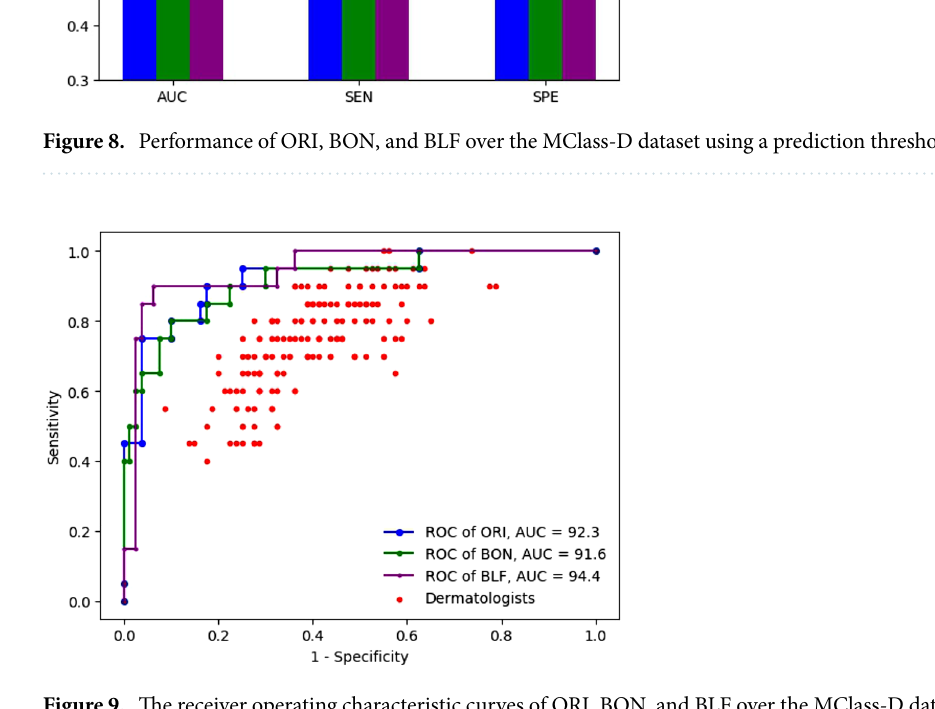
Comparison of the systems’ performance to that of dermatologists based on ROC curves. Figure 9 shows the ROC curves of the three best models (in blue, green, and purple, respectively for ORI, BON, and BLF) and the perfor- mance of the 157 dermatologists (with red dots). In full details, the AUC of the three models BLF, BON, and ORI respectively stands at 94.4%, 91.6%, and 92.3%, much higher than that of dermatologists (67.1%). There are 154 red points that show the performance (in term of SEN and SPE) of each dermatologist are below the BLF ROC curve, the remaining three points have the SEN of 100% with the highest SPE of 45% on the BLF ROC curve but 18.7% less than that of BLF model (45% vs 63.7%). This means that our BLF model surpasses the performance of every dermatologist. BLF is the best of all three models and has much better performance, being the first system to ever report results better than all of the 157 dermatologists involved in the system, with its AUC of 94.4%. The results of ORI and BON (92.3% and 91.6%) are better than those of 155 of the 157 dermatologists. All three models beat the state of the art, which only outperforms 136 of the dermatologists 26 . A more detailed analysis of the prediction thresholds is provided in Table 6. In Table 6, SOTA stands the performance of Brinker et al. 26 . As shown in Table 4, the AUC of the dermatologists 7 and of SOTA 26 were given for mean SEN and SPE of 74.1% and 60.0%. To ease comparison, Table 6 reminds these scores and provides the corresponding performance of all 3 models. At SEN 74.1%, BLF has a SPE of 97.5%, above the average of dermatologists by 37.3 percentage points, and above SOTA by 11 per- centage points. With SPE at 60.0%, the SEN of BLF reaches 100%, while ORI and BON both have SEN of 95%. All three have very high SEN compared to the mean of dermatologists (74.1%) and SOTA (87.5%). Among the group of dermatologists, “chief Physicians” have the highest mean SPE with 69.2% at a mean SEN of 73.3%. With the same SPE of 69.2%, BLF reaches a SEN of 90%, performing 16.7 percentage points higher than this subgroup of the most experienced dermatologists, and 5.5 percentage points higher than SOTA. However, at this level of SPE, ORI and BON actually perform even better in terms of SEN as they reach 95%. In addition to raising the AUC, the goal of this study is to manage to balance SEN and SPE in order to handle imbalanced dataset. In this respect, BLF proves most effective with SEN and SPE of 90% and 93.8%, surpassing